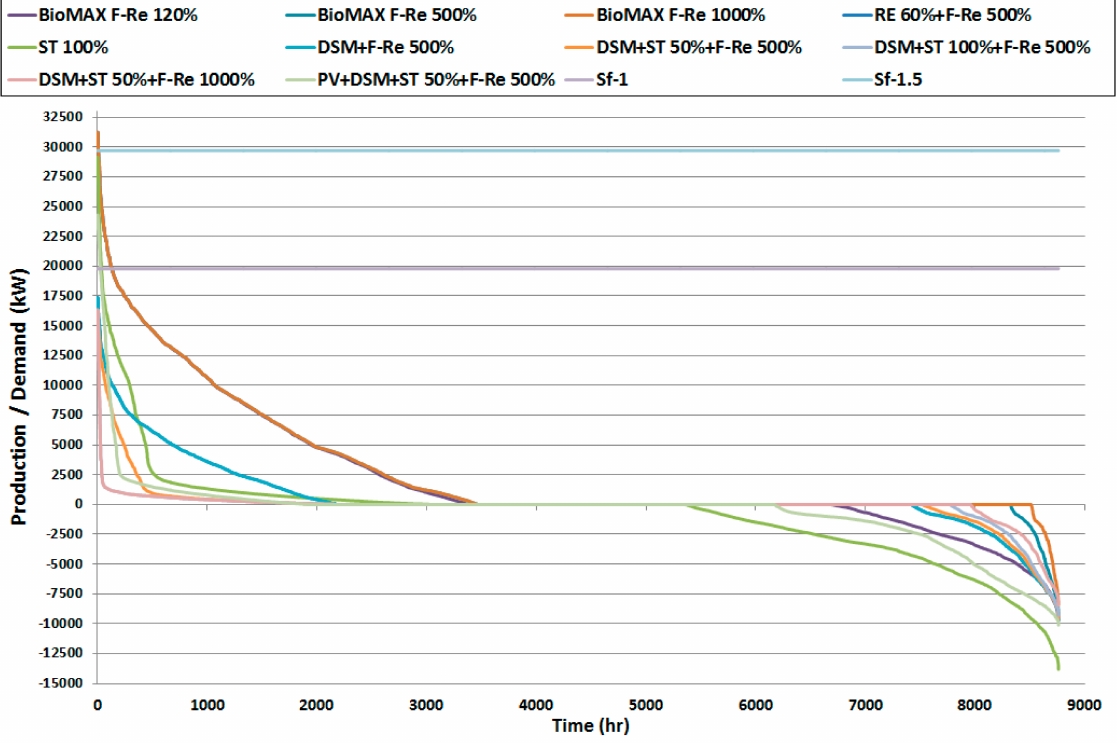
Figure A14. Main LDC results from the BioMAX